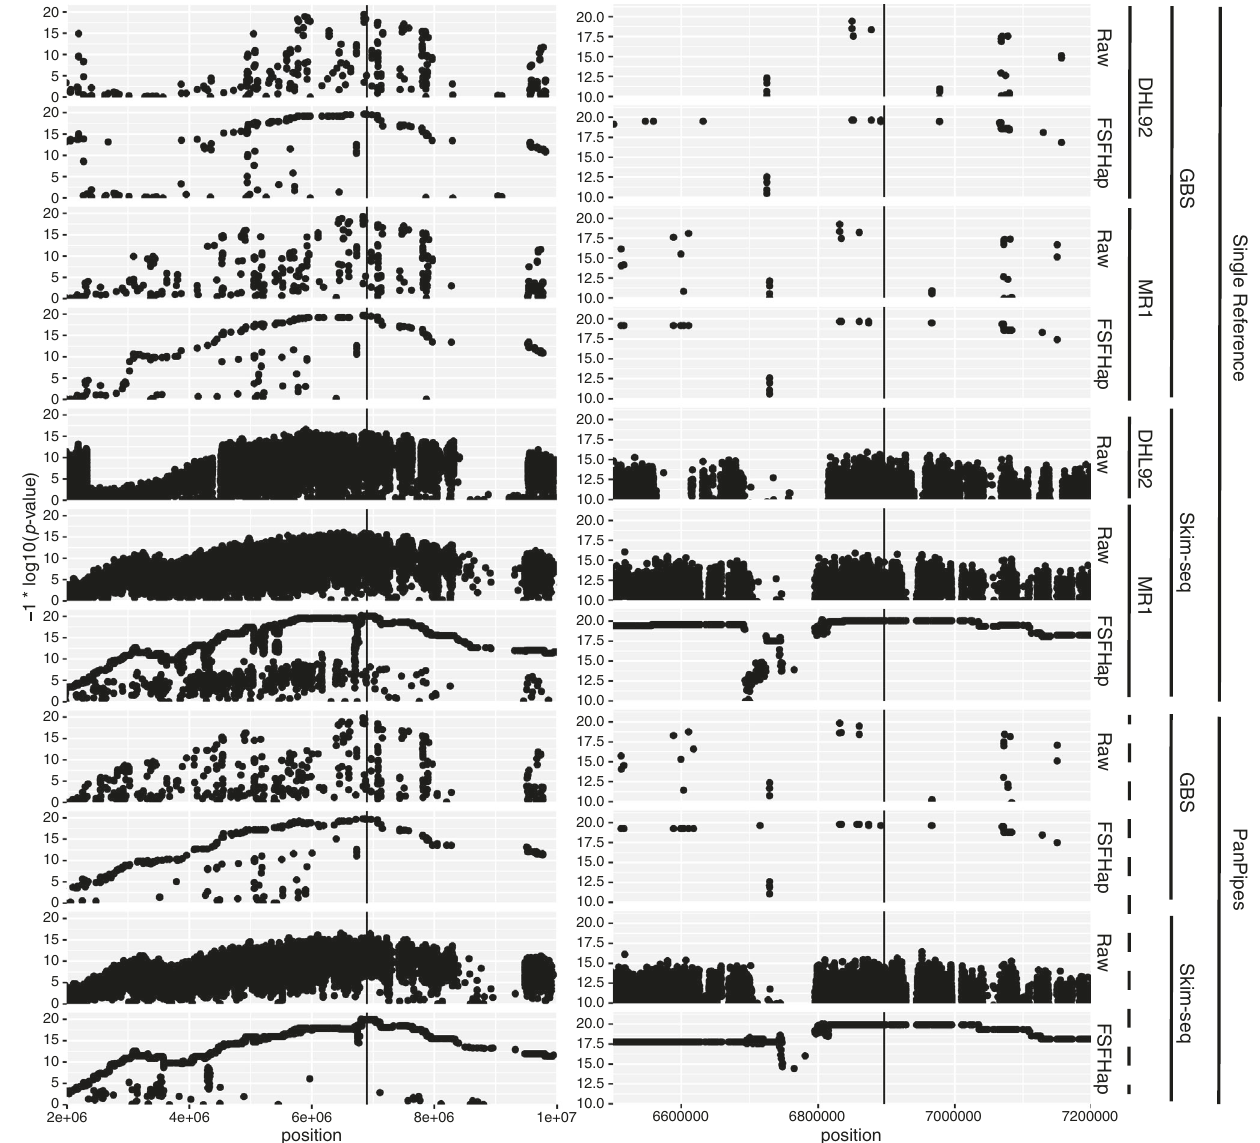
Fig. 4 | Genetic resolution of the fom2 locus using assorted methods. Both panels show association statistic for all variants across the fom2 interval (see “ Methods ” ). The chemical and analytical genotyping factor combinations are indicated at the far right. Because PanPipes uses both references simultaneously, this factor is shown as a dotted line. “ Raw ” indicates initial set of fi ltered variants